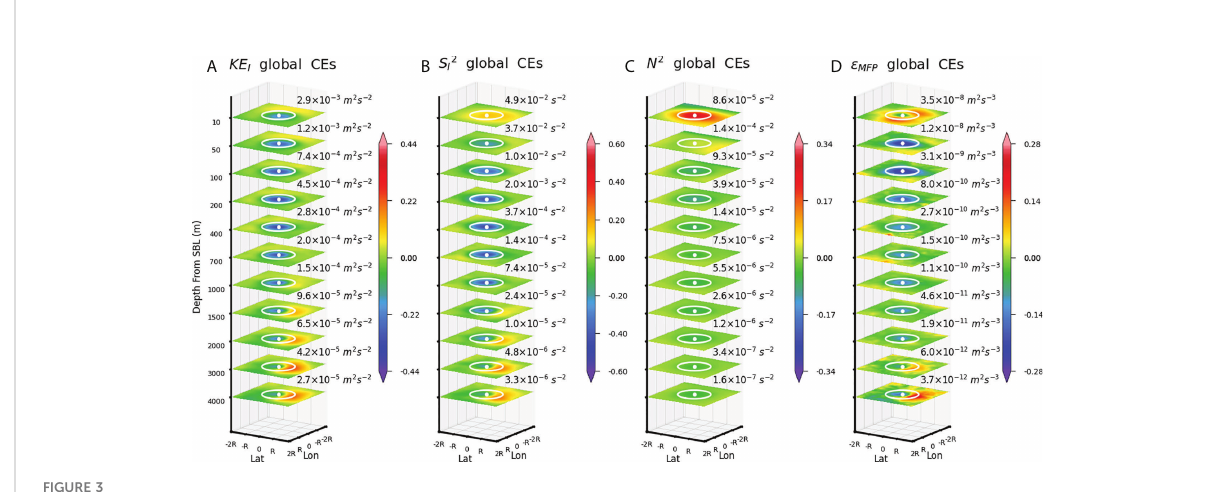
FIGURE 3 Same as Figure 2 but for CEs.